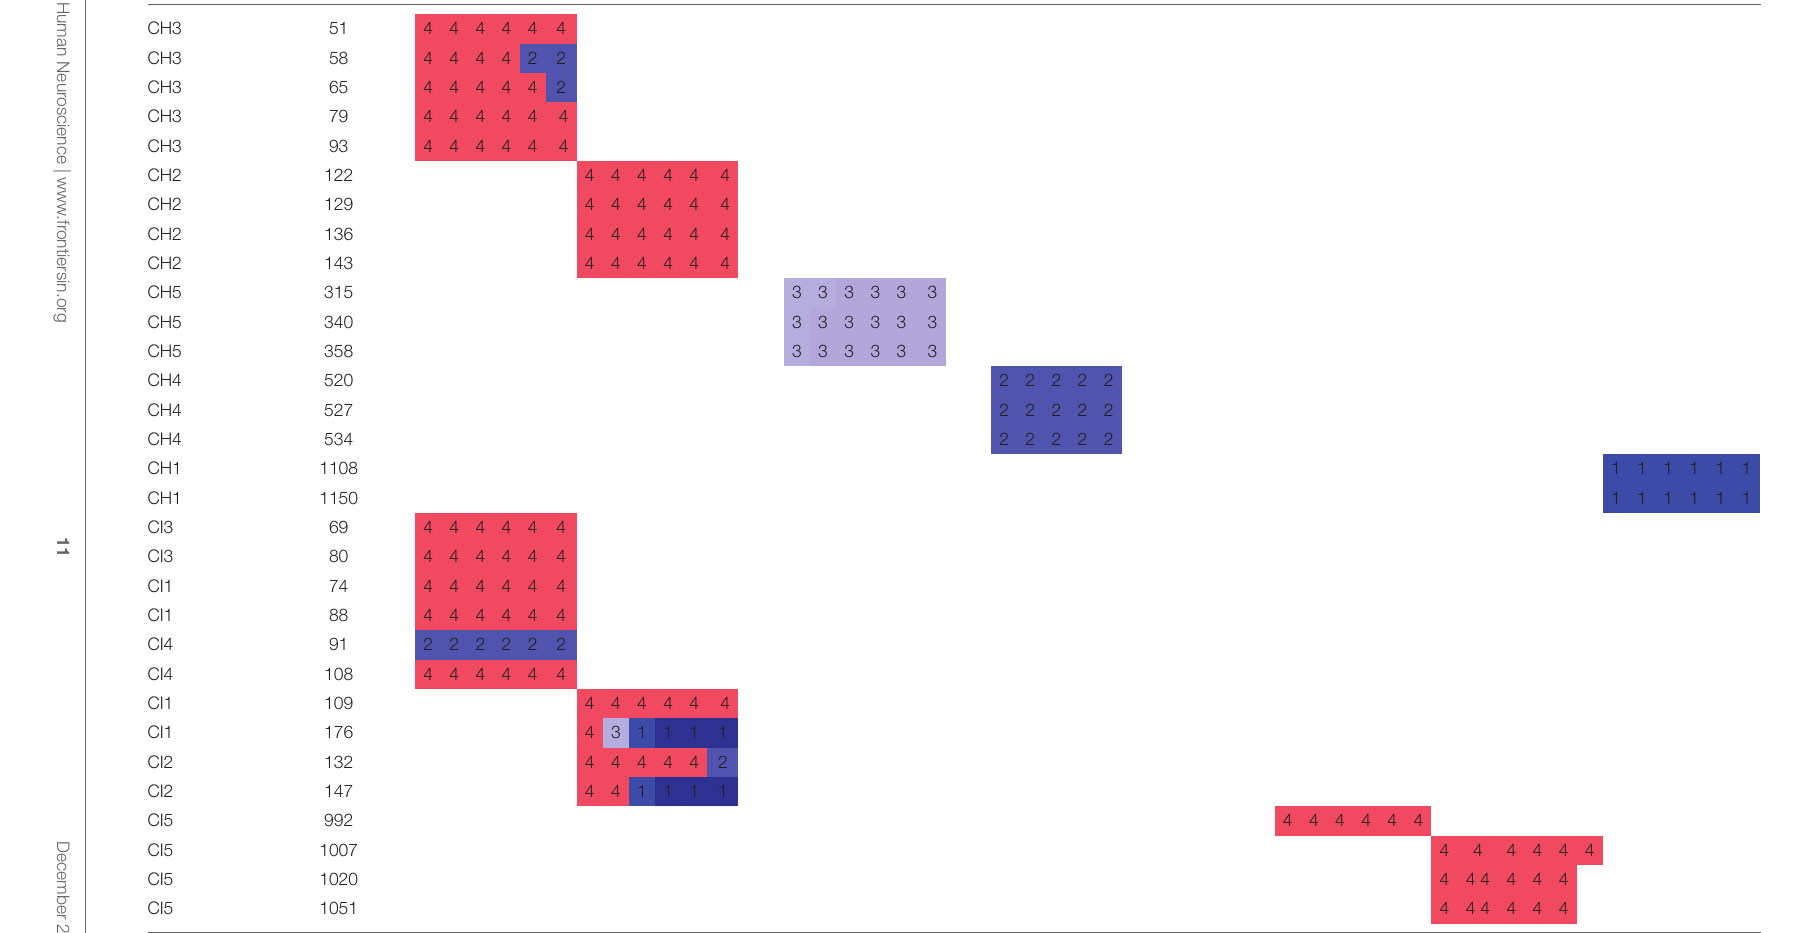
TABLE 6 | Clustering by days after onset to explore the transition pattern of days after onset in CH and CI. Name index Days after onset